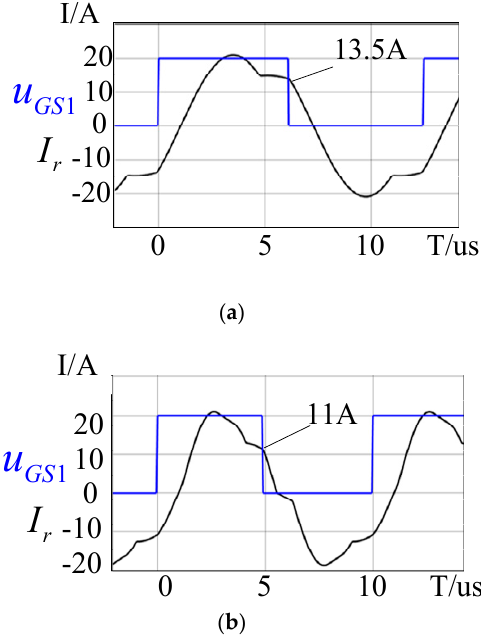
Figure 8. Current trend comparation of the LLSC converter and LLC converter at the same load. ( a ) LLC converter (80 kHz) and ( b ) LLSC (100 kHz).